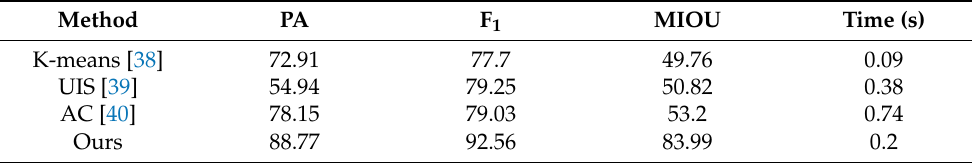
Table 2. Quantitative comparisons of models in the target domain.